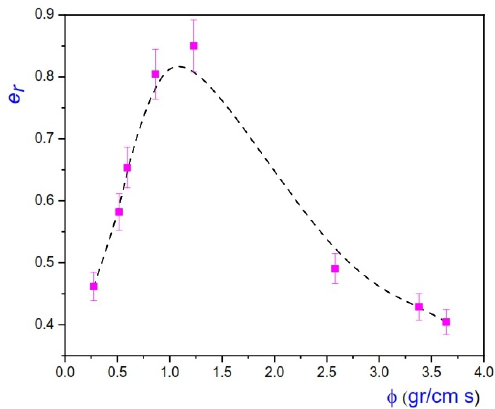
Figure 16. Plot of e r versus φ , where the occurrence of an optimal value can be observed at φ = φ opt ≈ 1.23 ± 0.06 gr/cm s. The dashed curve is used as a visual